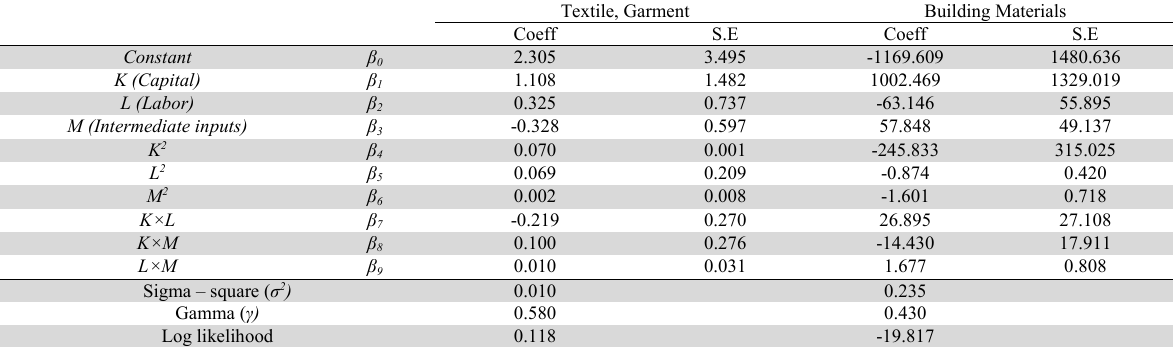
Estimated Frontier Production Function (continued)